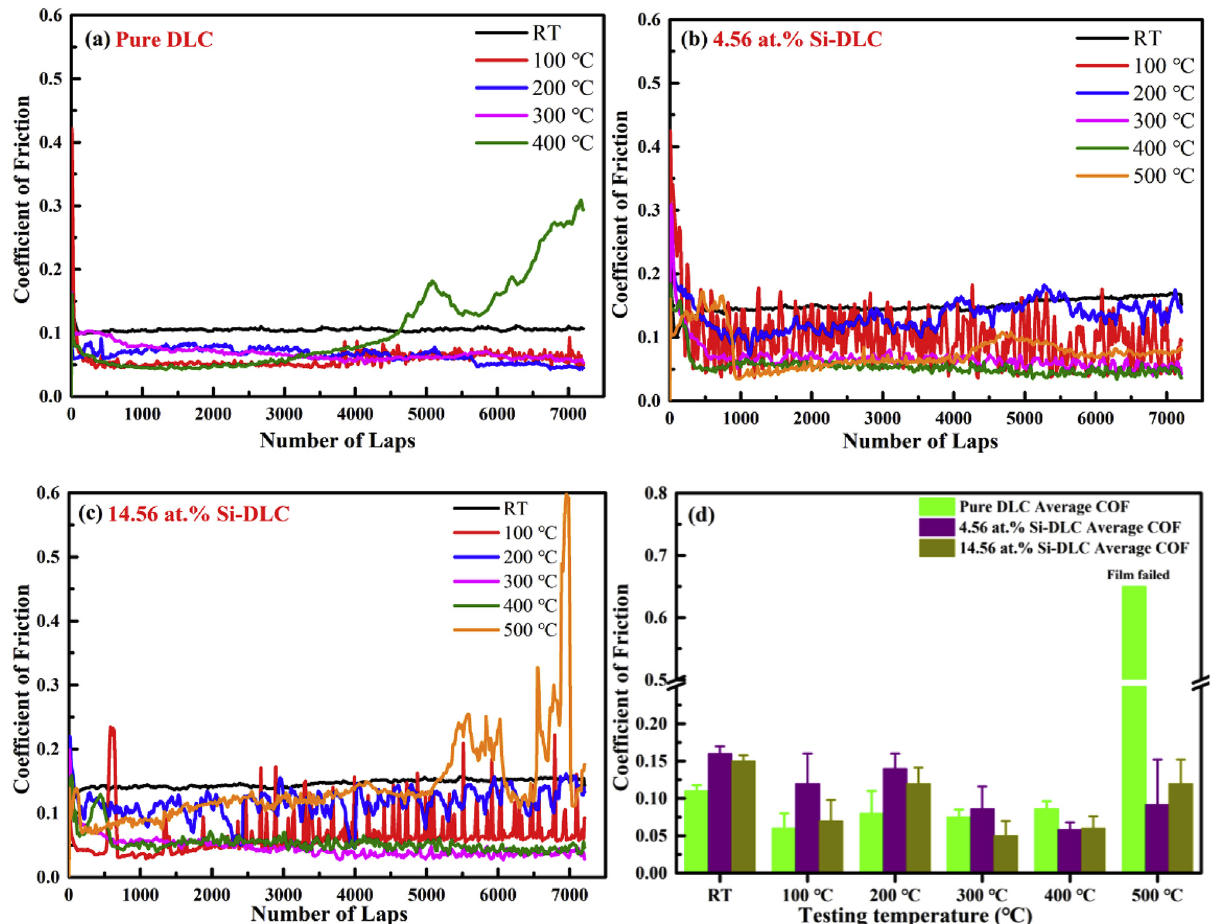
Figure 4: ( a ) Pure DLC, ( b ) 4.56 at% Si, and ( c ) 14.56 at% Si. ( d ) Steady state average CoF as a function of testing temperatures. Error bars are the standard deviations of the steady state values [ 45 ]